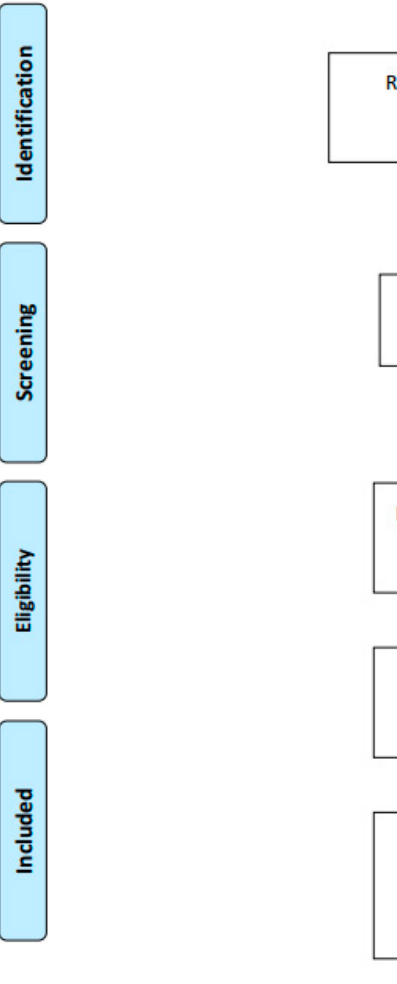
Figure 1. PRISMA diagram describing the process of study selection.